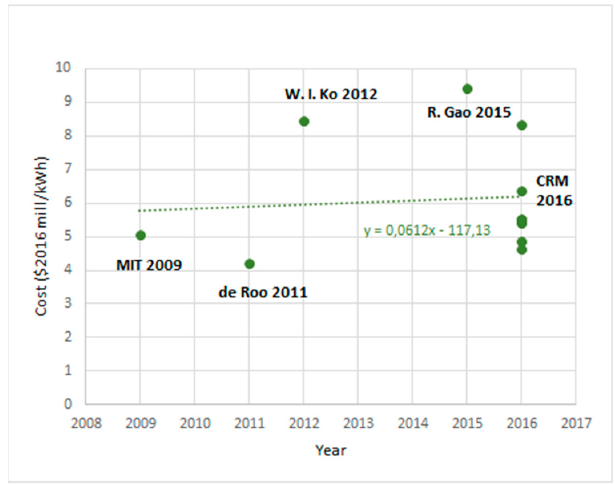
Figure 3. Evolution of advanced cycles cost.